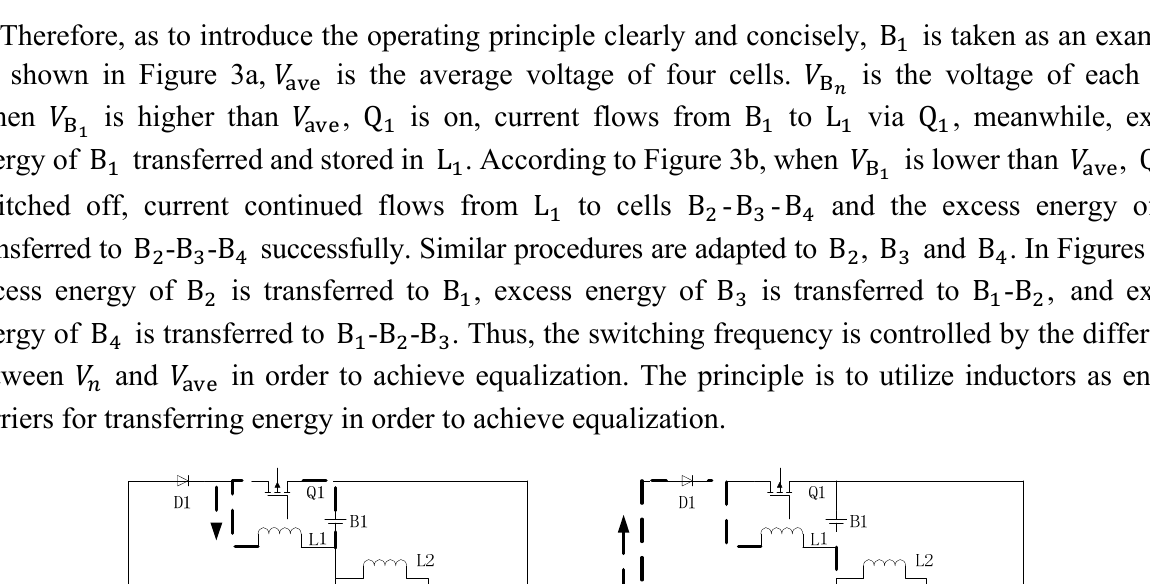
is switched on, current (cid:2869)